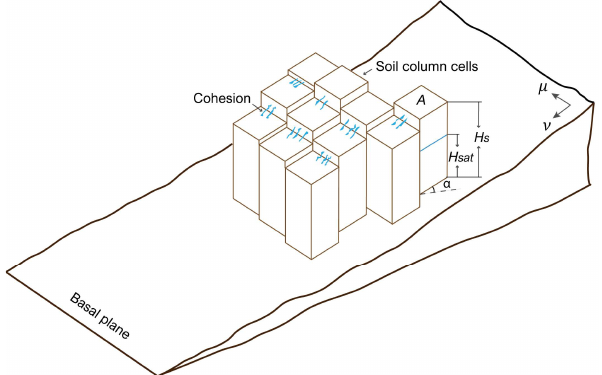
Figure 3. Sketch of a hillslope consisting of soil column cells.